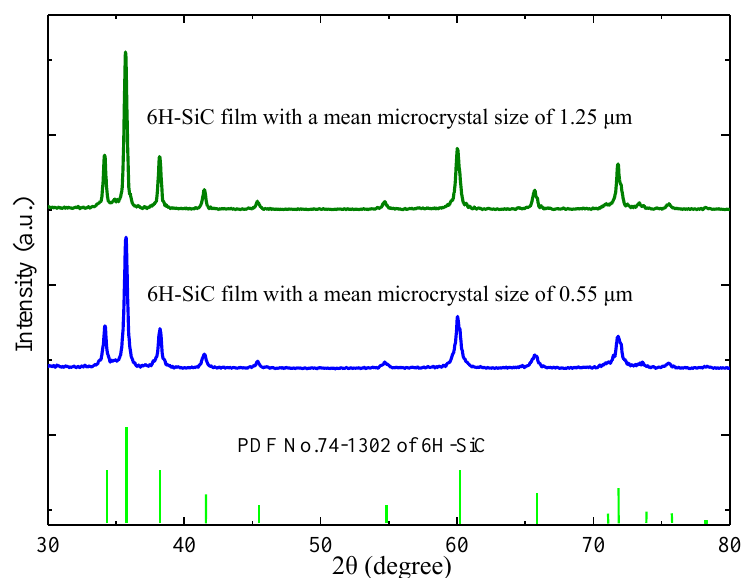
Figure 2. X-ray diffraction (XRD) patterns acquired from the 6H-SiC films with mean sizes of 1.25